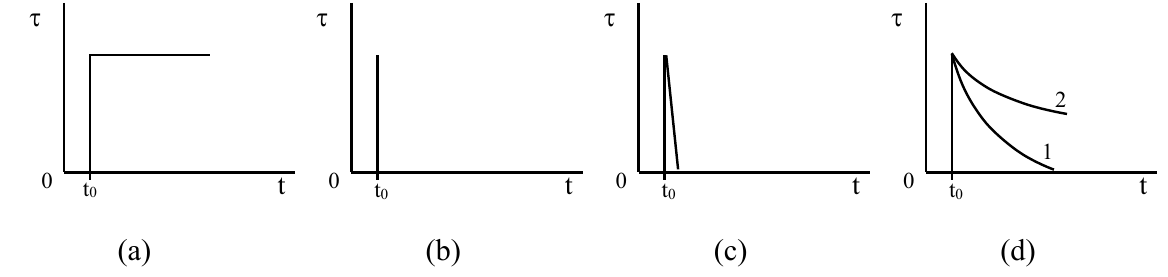
Figure 10: Typical relaxation curves of stress versus time under constant strain: (a) Hookean solid; (b) Newtonian liquid; (c) Water; (d) Viscoelastic liquids (1) and solids (2)